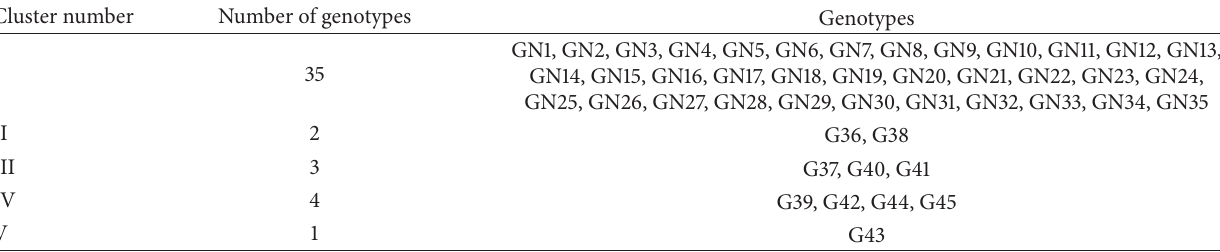
Table 6: Grouping of 45 genotypes according to cluster analysis.